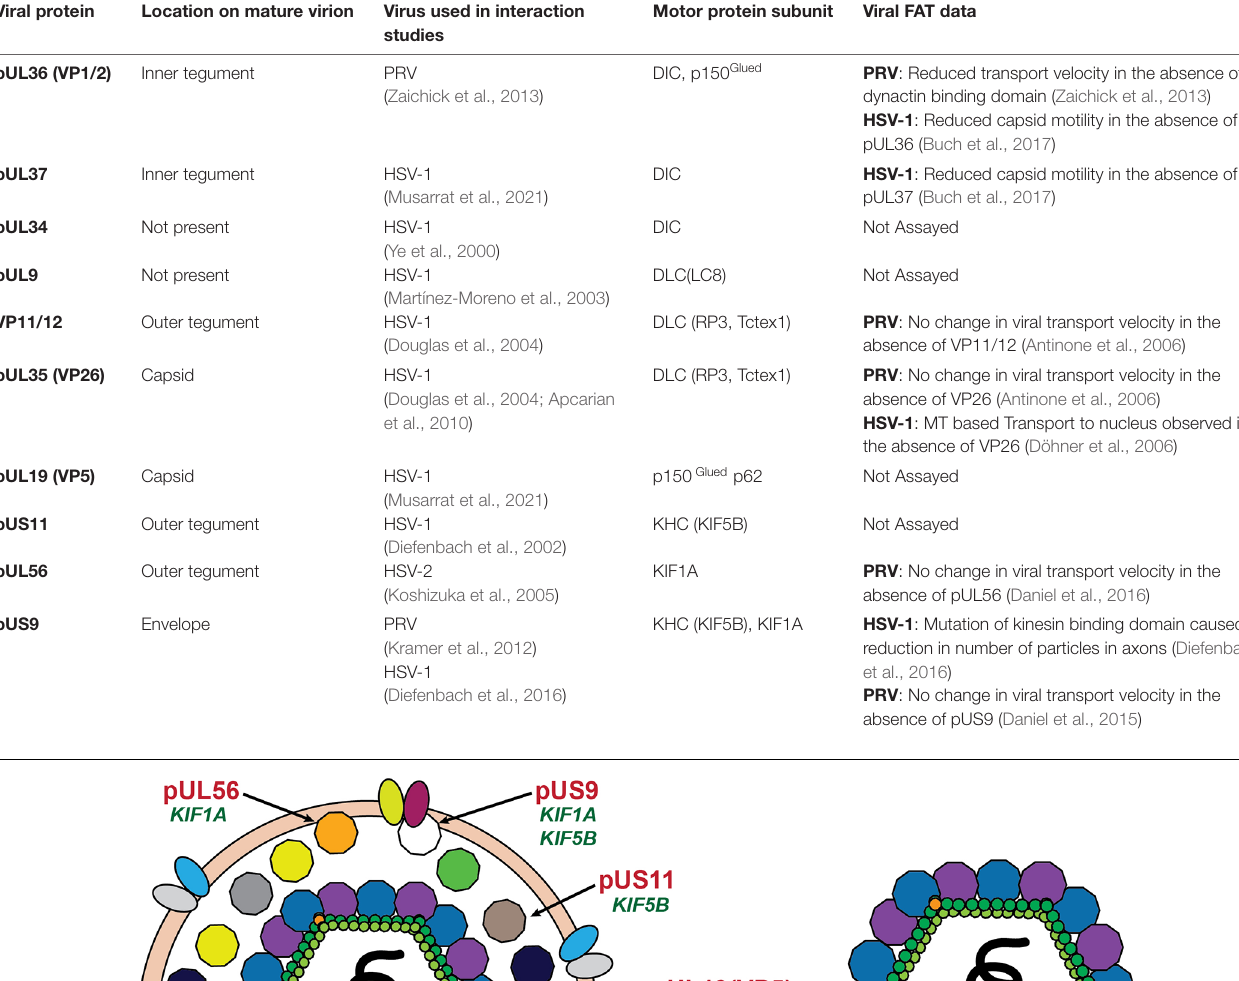
TABLE 1 | Reported interactions between alpha herpes virus proteins and microtubule-based motor proteins. Viral protein